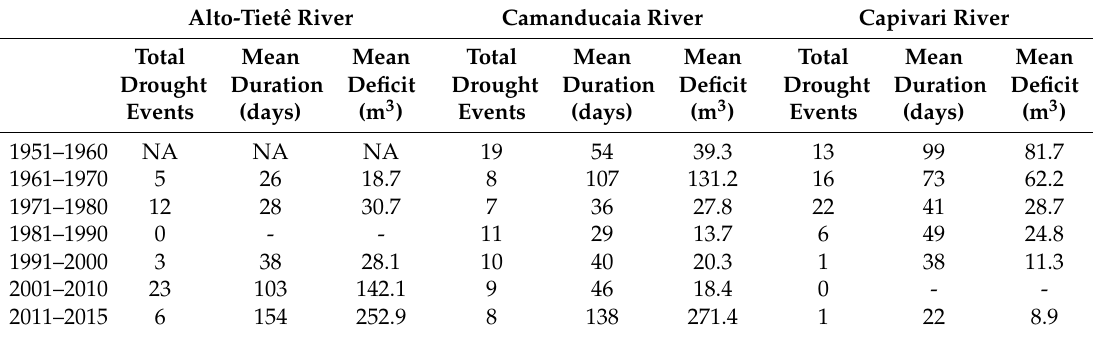
Table 2. Decadal characteristics of hydrological drought events that affected the Alto-Tiet ê , Camanducaia and Capivari